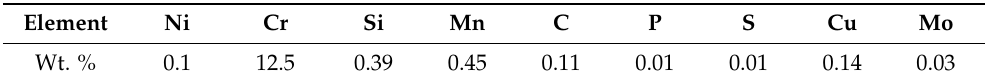
Table 1. Chemical composition of ER410 martensitic stainless steel.